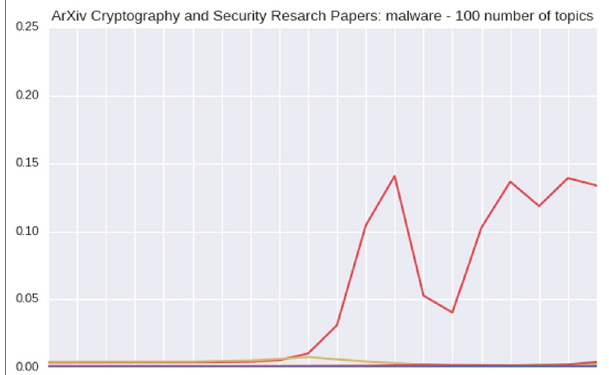
Frontiers in Big Data |